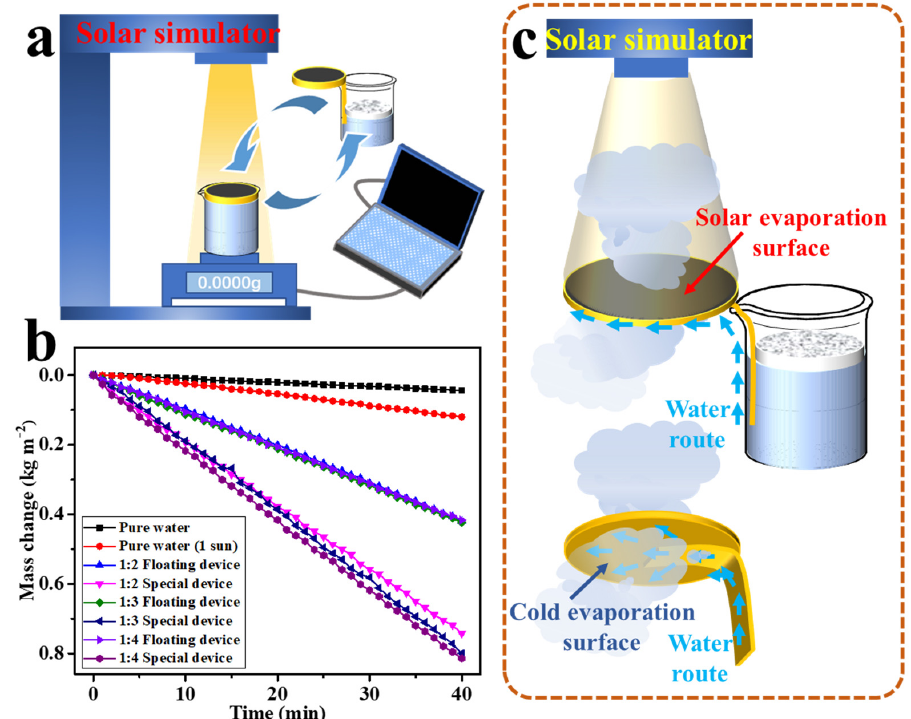
Figure 8. ( a ) Schematic diagram of solar-driven water evaporation experimental device; ( b ) mass changes of water with irradiation time in different evaporation modes under 1 sun; ( c ) schematic diagram of solar-driven interface evaporation process via tail swabbing mode.